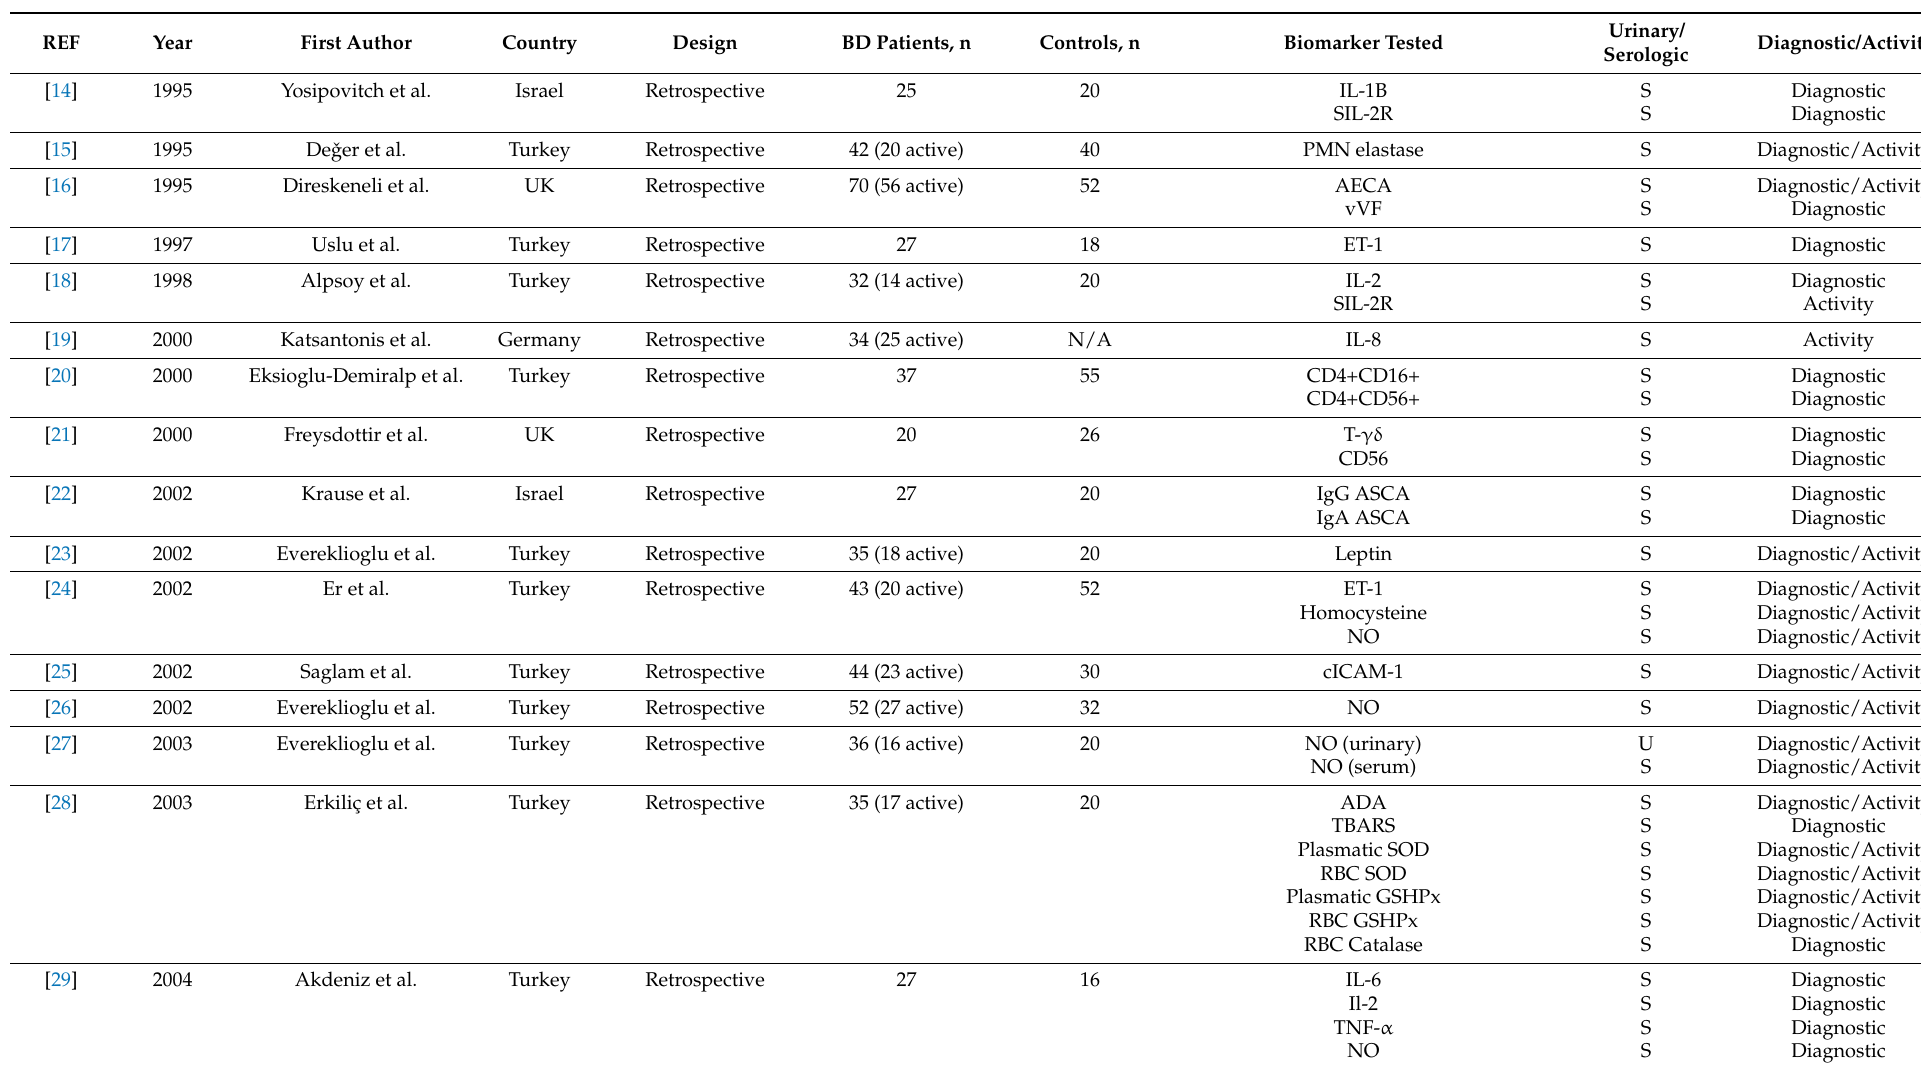
Table 1. Main characteristics of the studies included in the